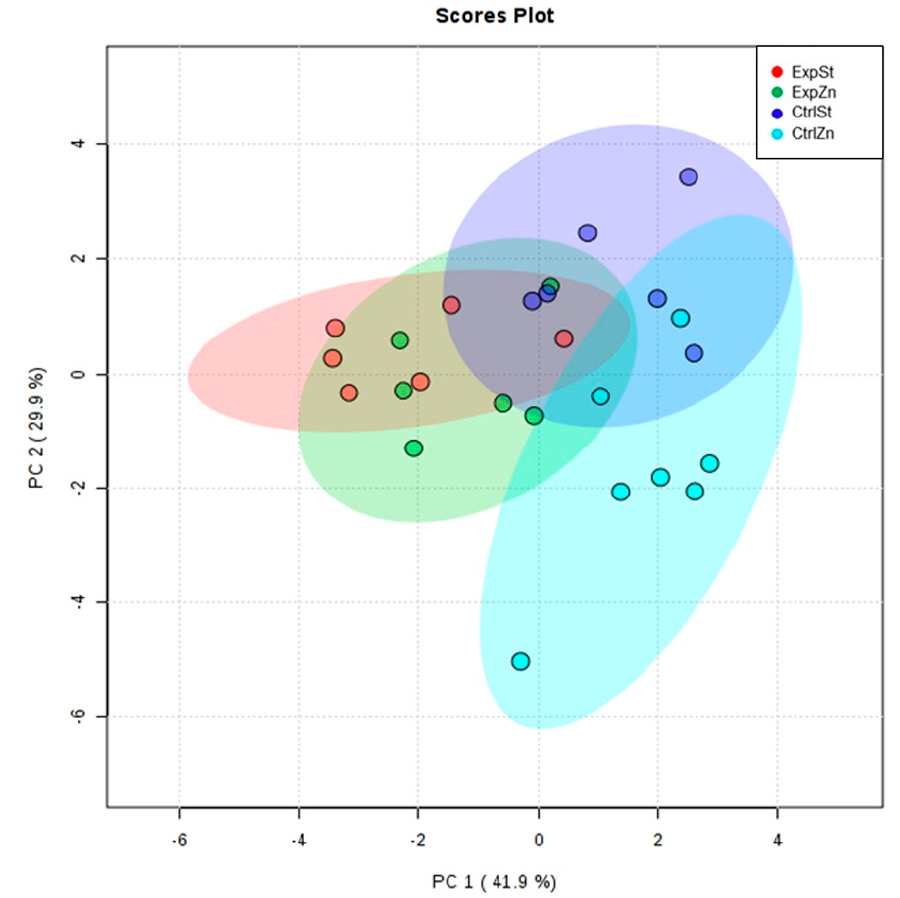
Figure 5. The Principal Component Analysis performed on four groups—rats on the standard diet with LNCaP (red dots—ExpSt); rats on the standard diet without LNCaP (blue dots—CtrlSt); rats with Zn supplementation with LNCaP (green dots—ExpZn); rats with Zn supplementation without LNCaP (light blue dots—CtrlZn).